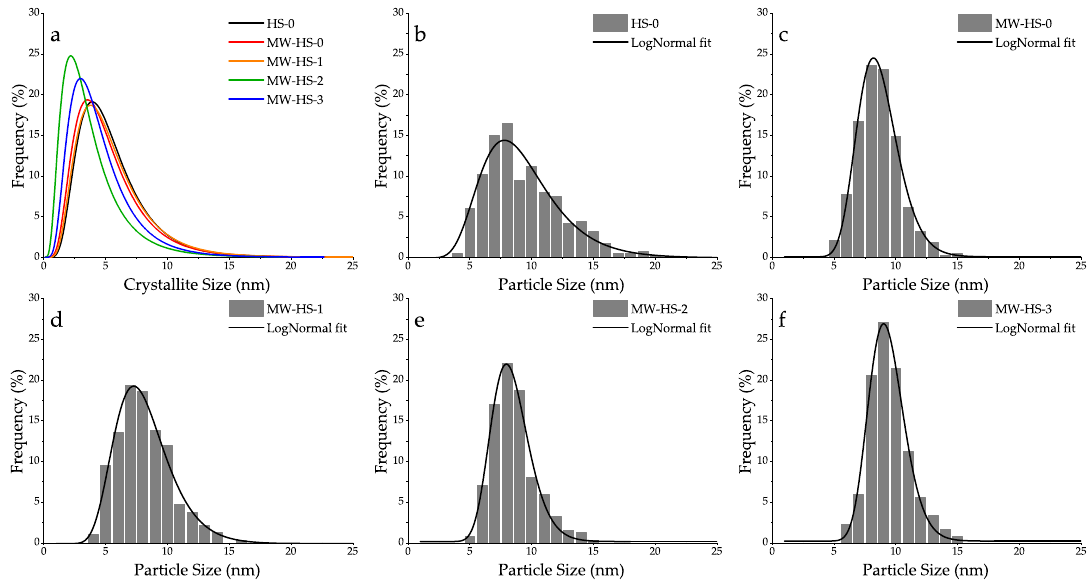
Figure 2. Size distribution curves of ( a ) crystallite size of all samples calculated by the WPPM method; and TEM particle size distribution curves for ( b ) HS-0, ( c ) MW-HS-0, ( d ) MW-HS-1, ( e ) MW-HS-2, ( f ) MW-HS-3